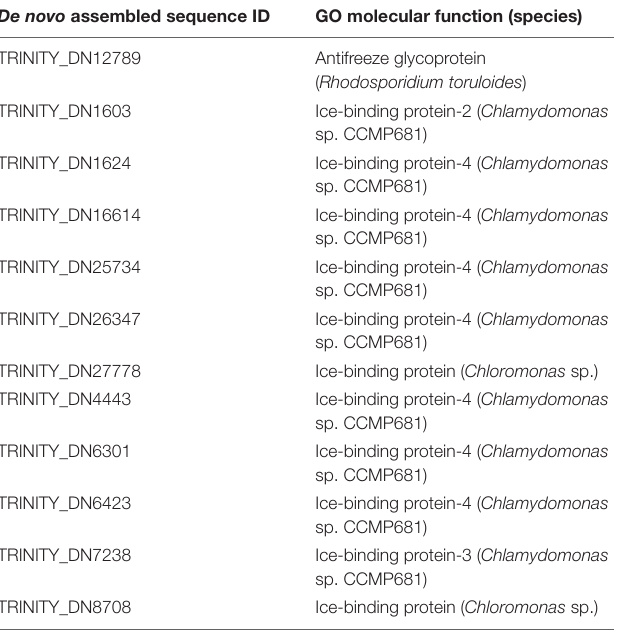
TABLE 3 | Putative Antifreeze and Ice-Binding proteins found in transcriptome of Chlorominima collina. De novo assembled sequence ID GO molecular function (species)